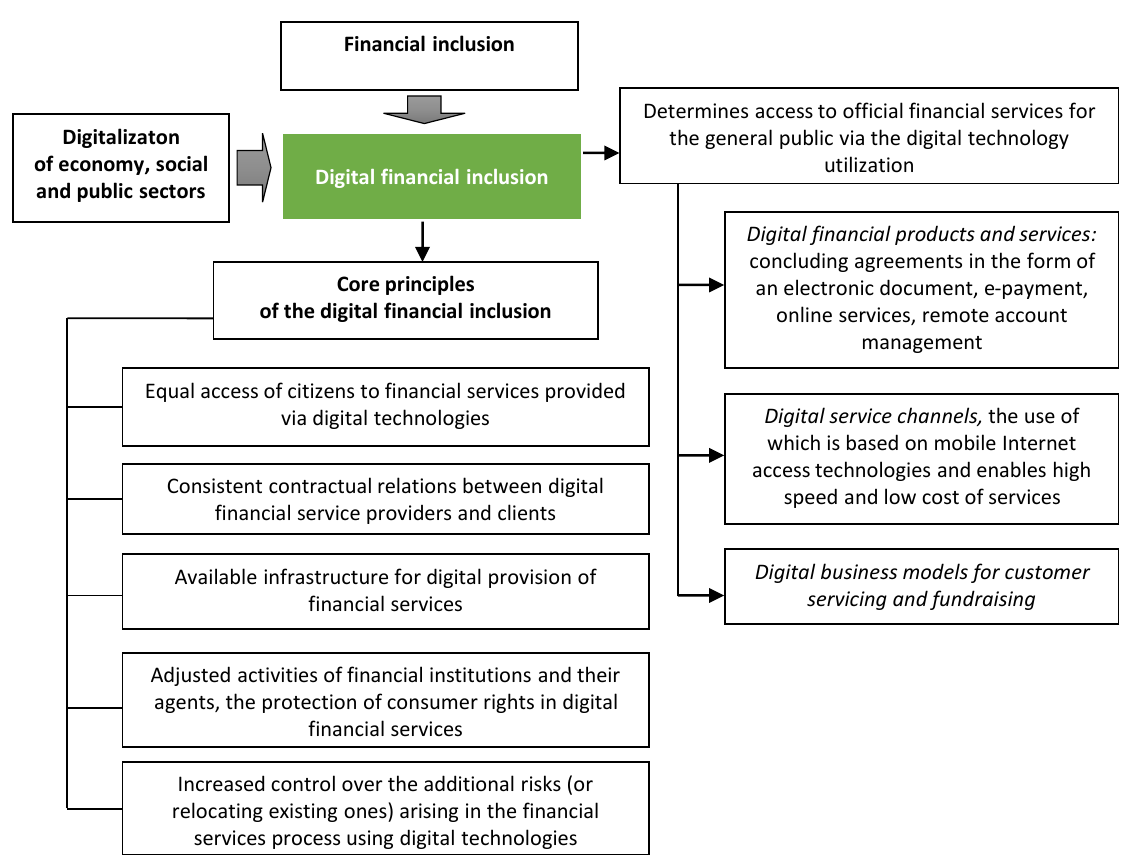
Figure 1. The digital financial inclusion